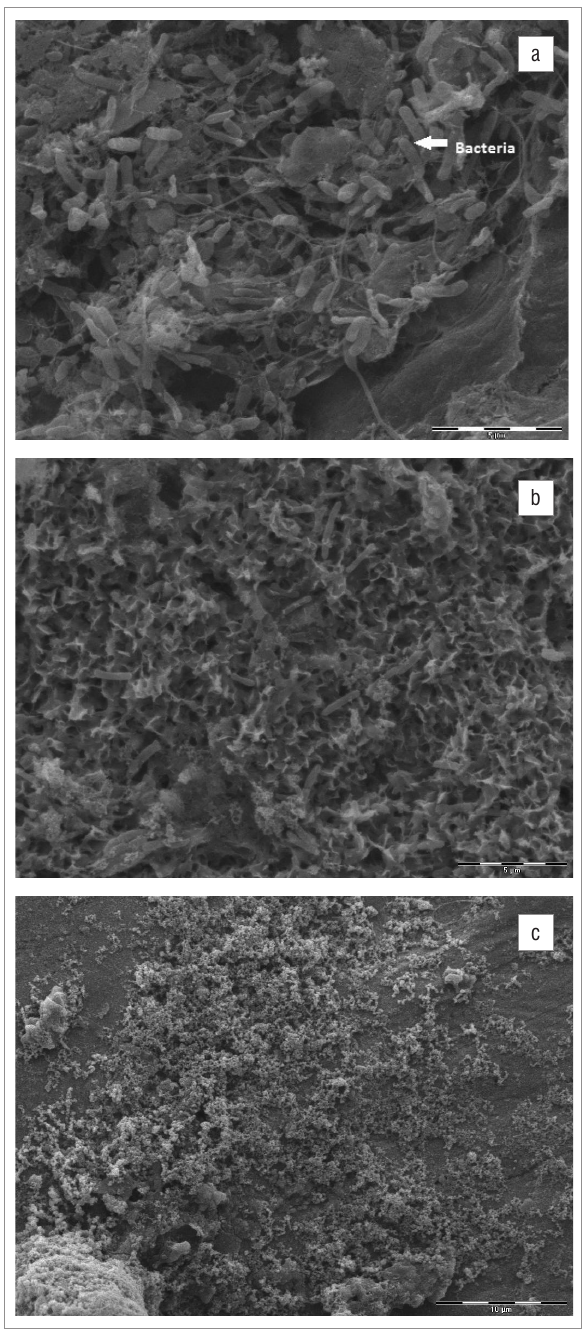
Figure 5: Electron micrographs of biofilm collected using carbon filters from (a) mixed water, (b) Modimola Dam and (c) Molopo Eye.